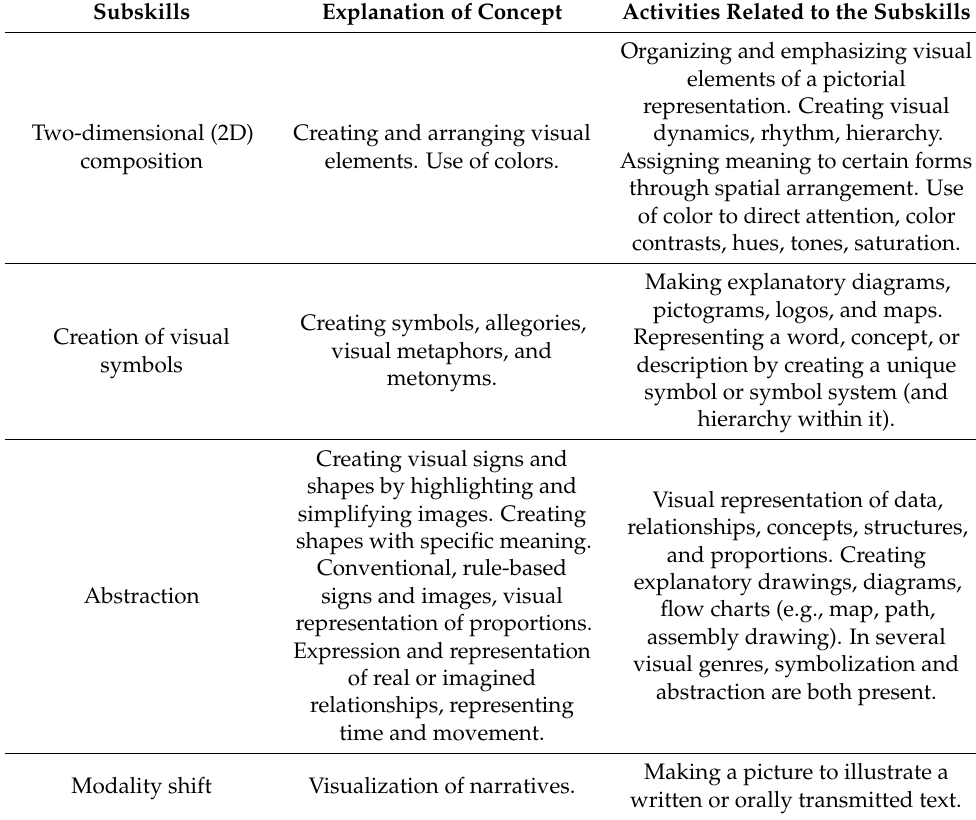
Table 1. The subskills selected to assess the “produce” domain of visual communication. Subskills Explanation of Concept Activities Related to the Subskills Organizing and emphasizing visual elements of a pictorial representation. Creating visual dynamics, rhythm, hierarchy. Two-dimensional (2D) Creating and arranging visual composition elements. Use of colors. Assigning meaning to certain forms through spatial arrangement. Use of color to direct attention,